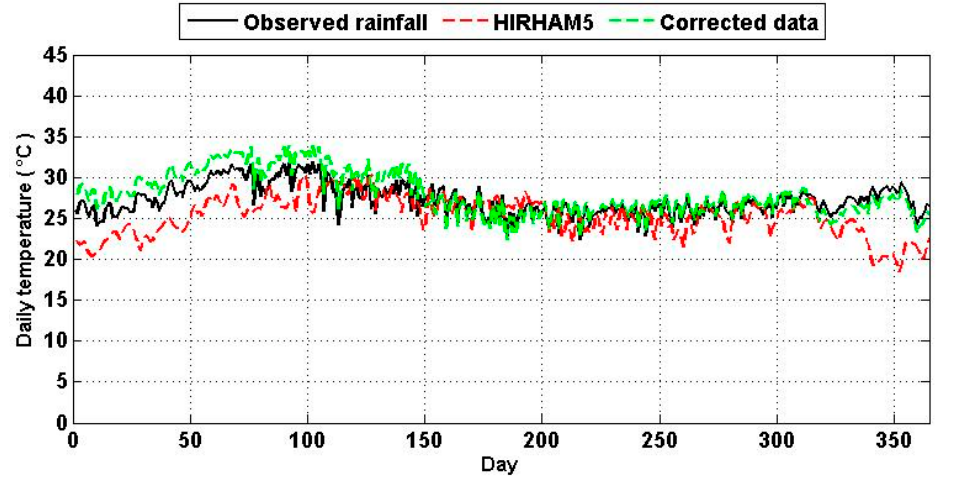
Figure 6. Example based on mean daily temperature in Bétérou catchment from observations (1961–1990), HIRHAM5 and corrected temperature.